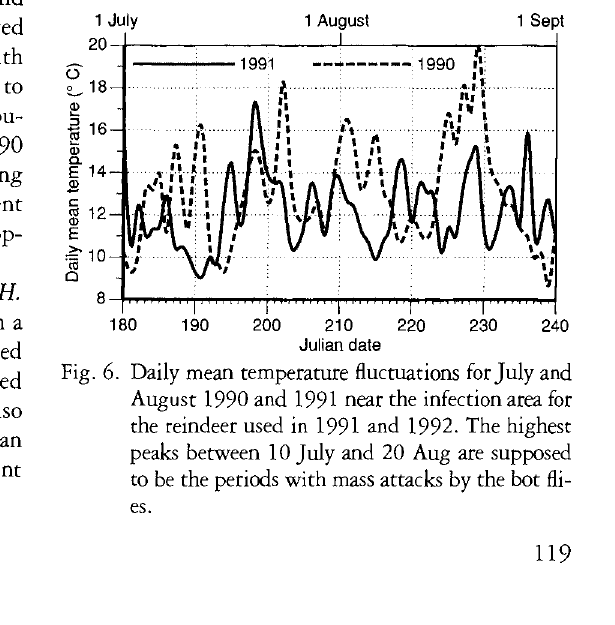
Fig. 6. Daily mean temperature fluctuations for July and August 1990 and 1991 near the infection area for the reindeer used in 1991 and 1992. The highest peaks between 10 July and 20 Aug are supposed to be the periods with mass attacks by the bot fli